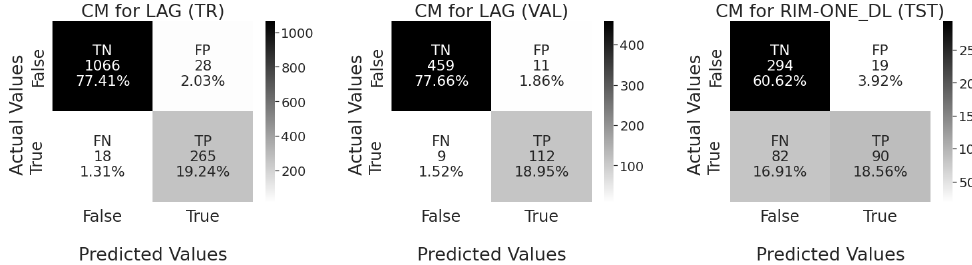
Figure 7. Confusion matrix of MobileNet_v2 trained parameters for GON-OD.